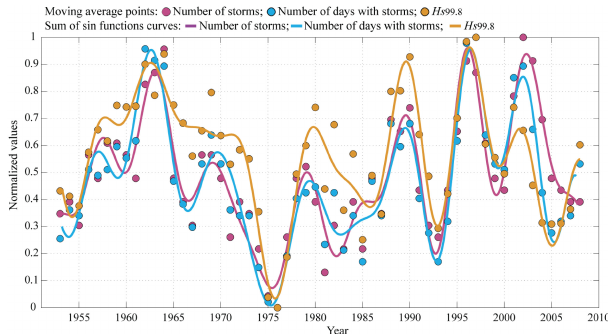
Fig. 4. Normalised and smoothed annual storm parameters and H s99 . 8 . A sum of sin functions is fitted to each